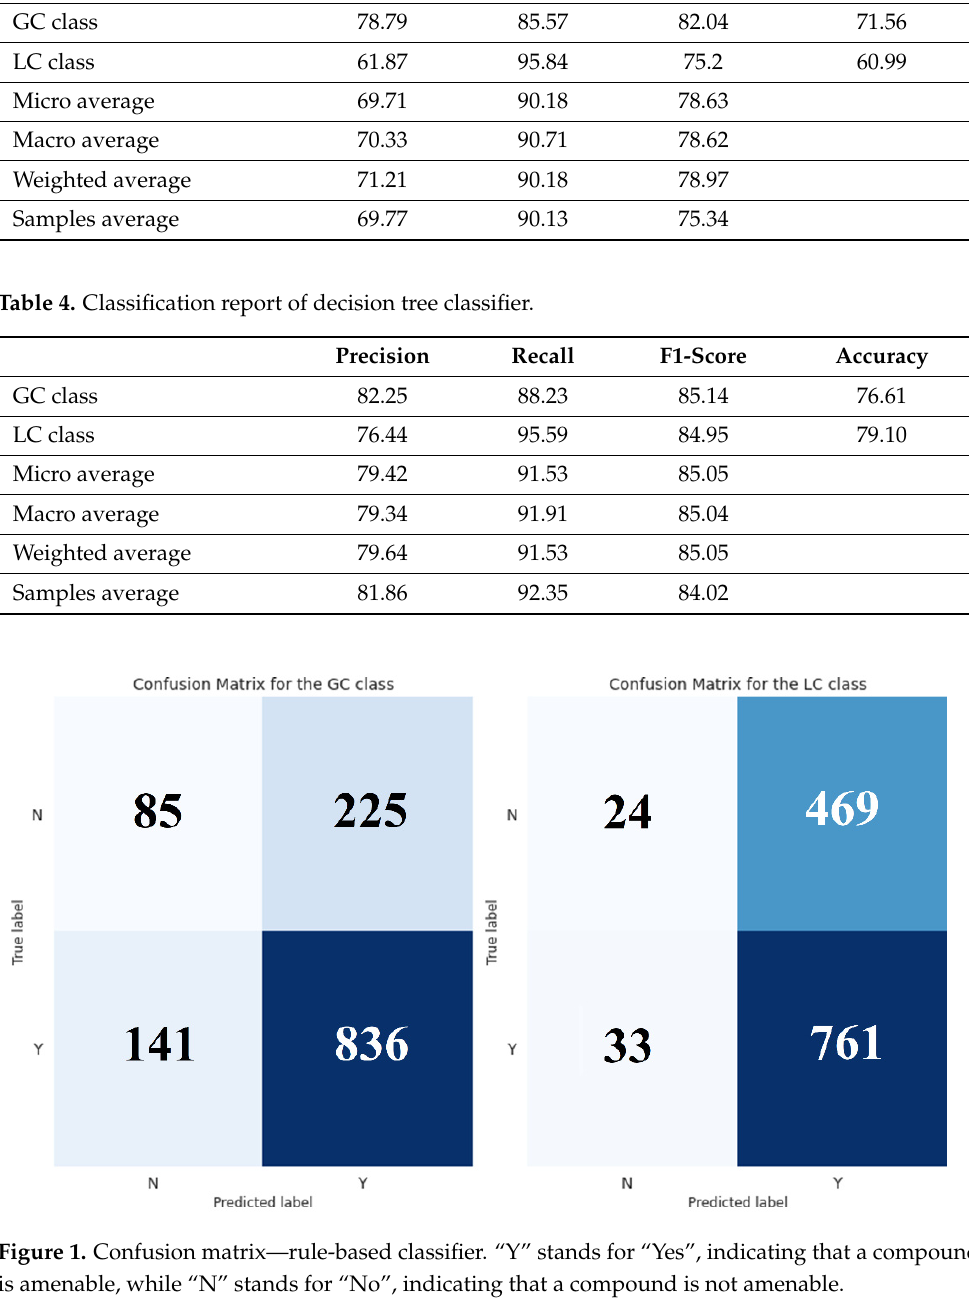
Figure 2. Confusion matrix—decision tree classifier. “Y” stands for “Yes”, indicating that a com ‐ pound is amenable, while “N” stands for “No”, indicating that a compound is not amenable. Table 3. Classification report of rule ‐ based classifier. Precision